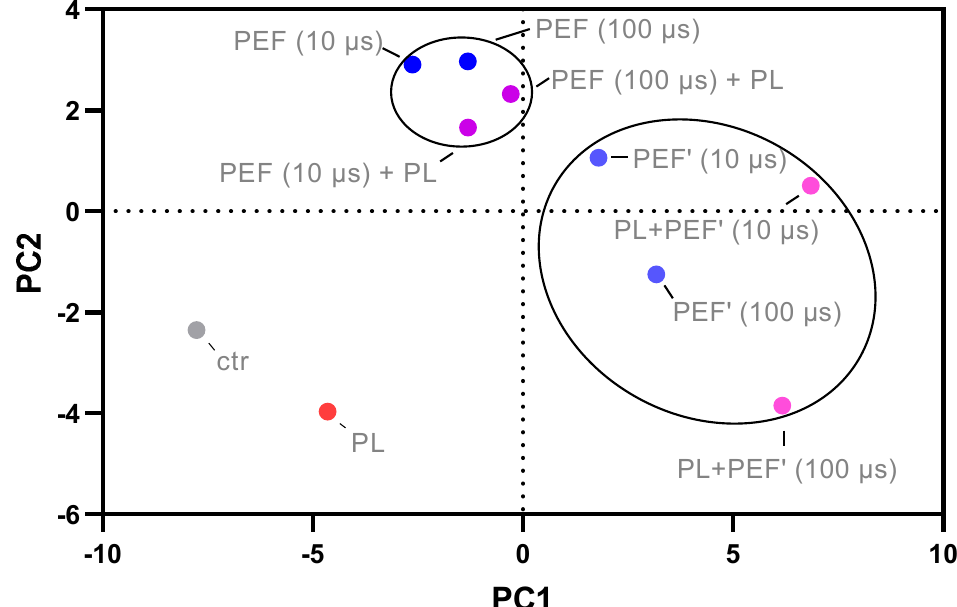
Figure 6. Principal component (PC) analysis of cell viability and number, intracellular ROS, thiol content, and mitochondrial membrane potential. The treatment order of plasma first and PEF second varied the most from the single applications.